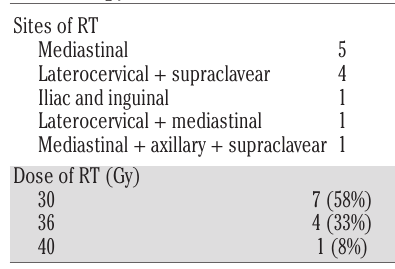
Table 2. Sites and dose of RT received by the patients in combination with ICI. RT: